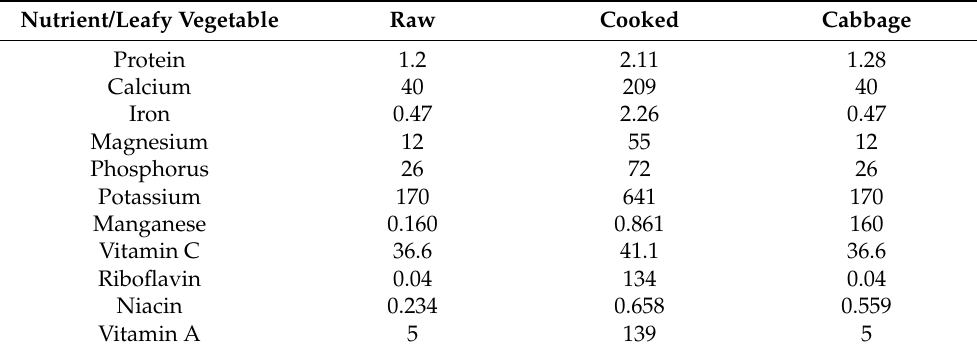
Table 4. Nutritional value of raw and cooked (boiled and drained without salt) amaranth leaves compared with raw cabbage. Source